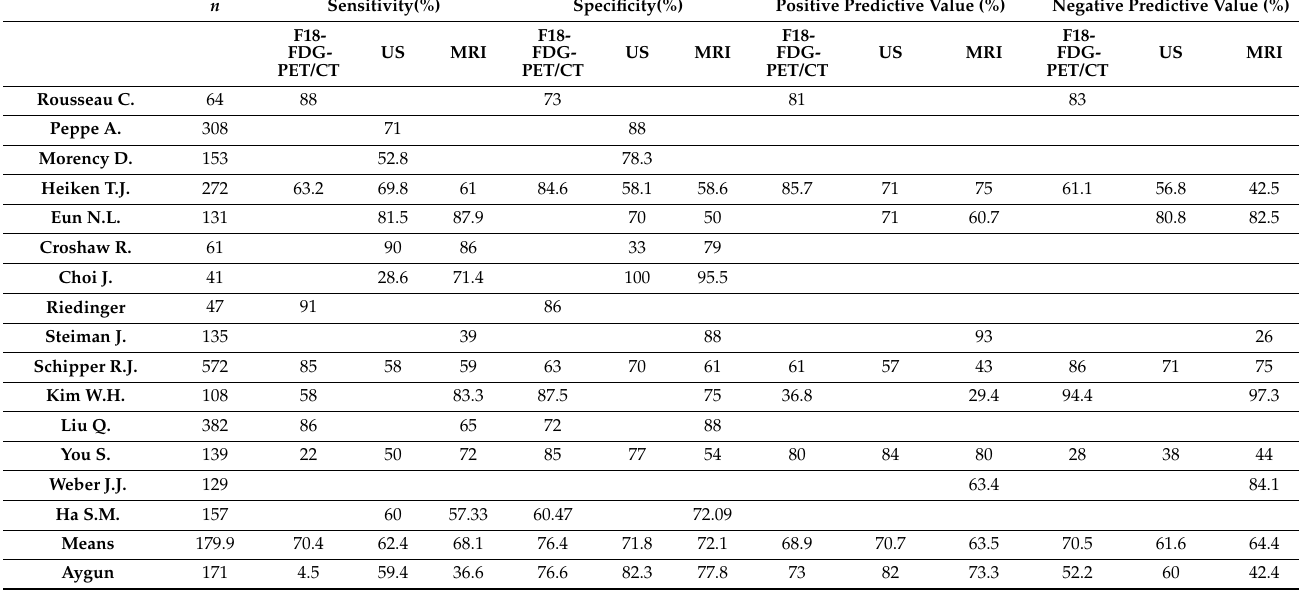
Table 5. Outcomes and mean values of previous